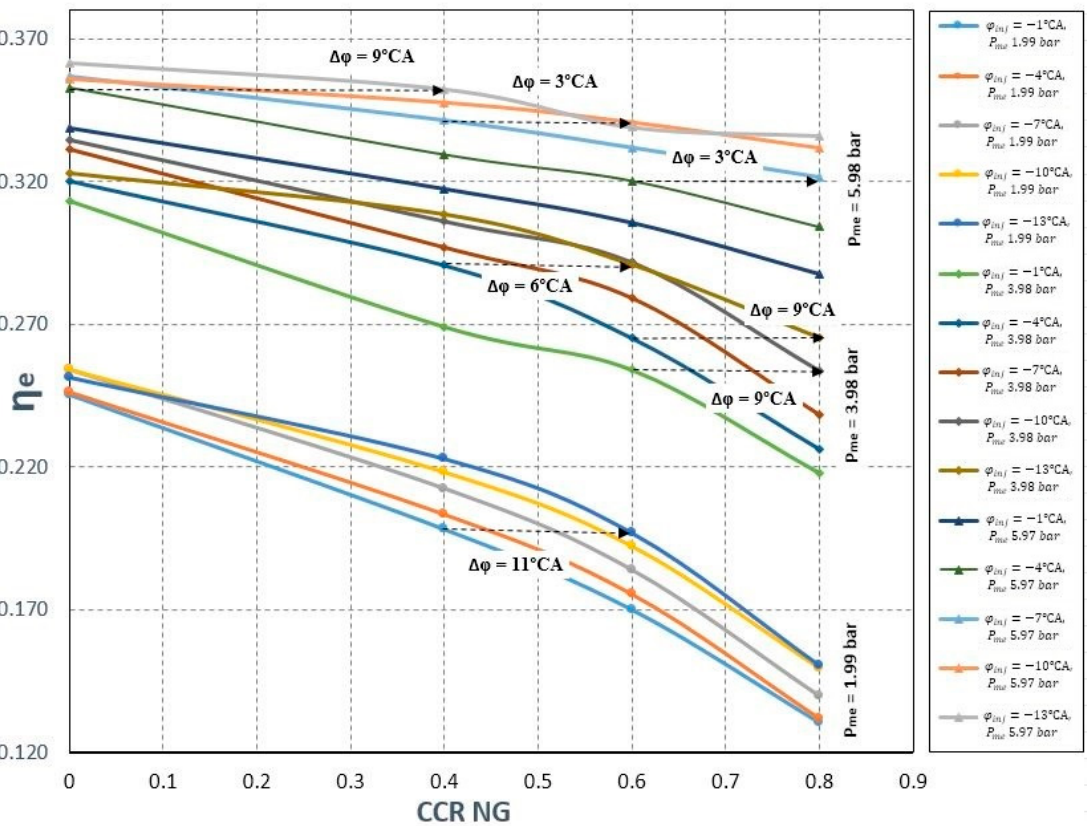
Figure 3. Influence of CCR NG portion increase on diesel engine η e .